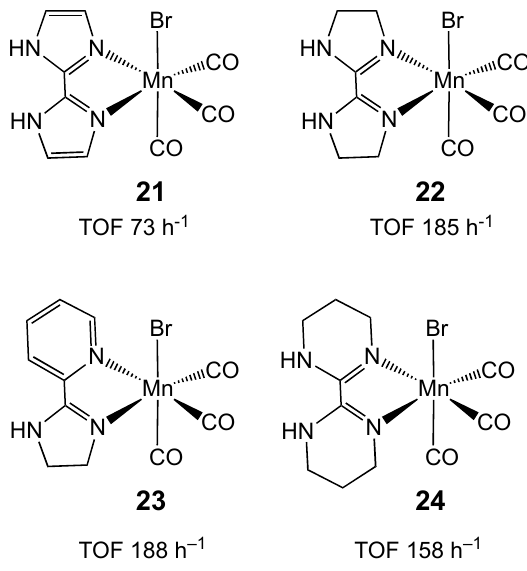
Figure 4. Examples of Mn(I)- κ 2 - N - N catalyst precursors.